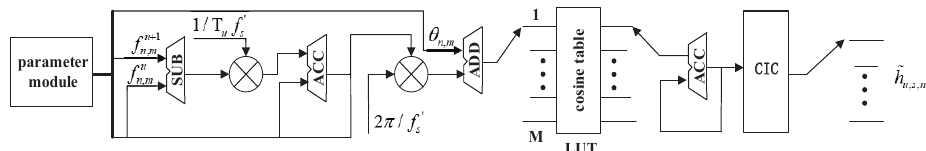
Figure 5. The implementation scheme of channel fading module.